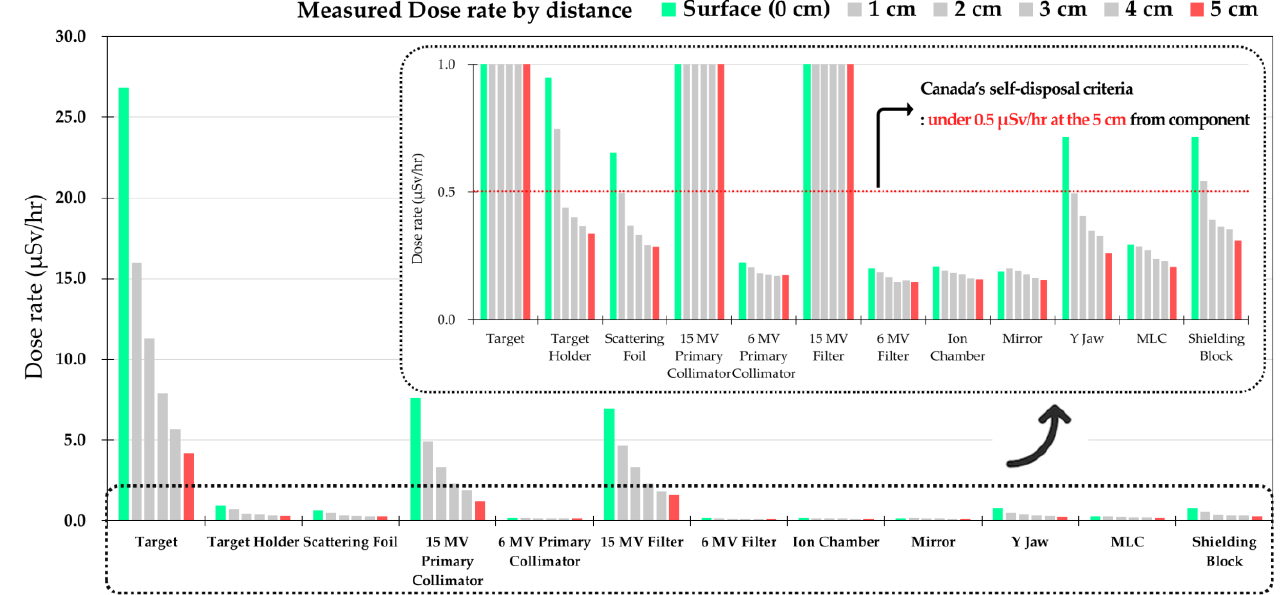
Figure 4. Dose rate of the component by distance: 0 cm to 5 cm from the surface.